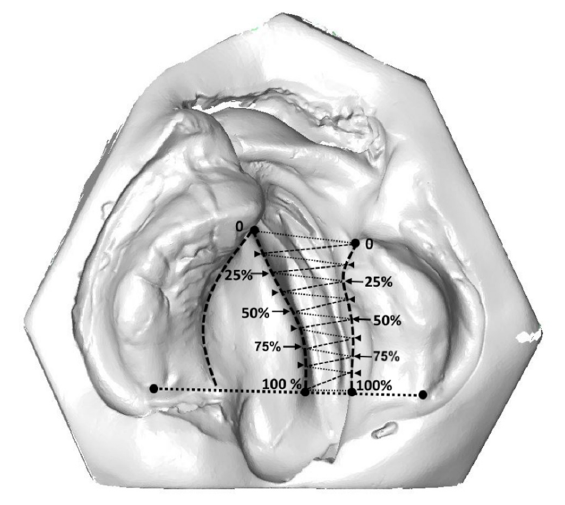
Figure 3. True cleft area measurement connecting equidistant points from the vomer edge to the lesser palatal shelf ridge (0% and 0%, 12.5% and 12.5%, and so forth) led to 8 equidistant quadrangles, which were split into two triangles each, leading to a total of 16 triangles. Surface measurements of defined areas were then approximated as the sum of its comprising